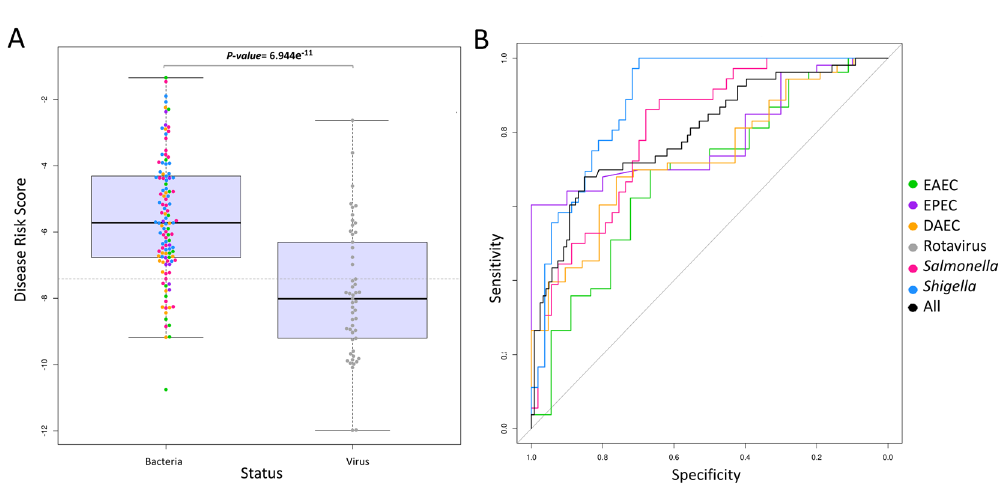
Figure 2. Classification performance based on the 2-transcript DRS combined as [log2( FAM89 expresion)– log2( ILF44L expression)]. ( A ) Box and whisker plot of DRS: the horizontal lines in the boxes indicate the median of each group; the lower and upper edges of boxes reflect interquartile ranges, and the whiskers are < 1 times the interquartile range; the horizontal grey line is the DRS threshold that maximizes the AUC when comparing patients with viral and bacterial infections. ( B ) ROC curves of different bacteria compared to rotavirus; the different colors identify the type of bacteria according to the inset legend. AUC values are provided in Table